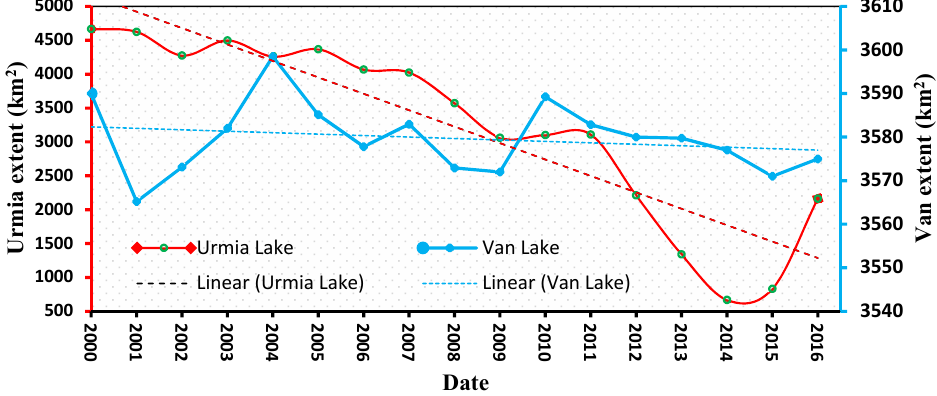
Figure 4. Annual changes in surface area of LU and LV and the trend in surface area change for the 17-year period from 2000 to 2016. The LU surface area was at its lowest in 2014, about 14% of what it was in 2000. In comparison, the surface area of LV was relatively steady during this period. From 2000 to 2016, the maximum water level of LU (1273.8 m) was in 2000, while the highest in LV (1647.8 m) was in 2007 (Figure 5). The lowest water levels in 2014 were 1270.1 m in LU (a loss of roughly 3.75 m) and 1647.0 m in LV (a loss of approximately 0.8 m) in 2002. In general, a decreasing tendency in water level (average of around 0.21 m/year) was recorded for LU. On the other hand, from 2000 to 2016, the overall change in water level for LV was close to zero or slightly positive (10 cm/year) (Figure 5).